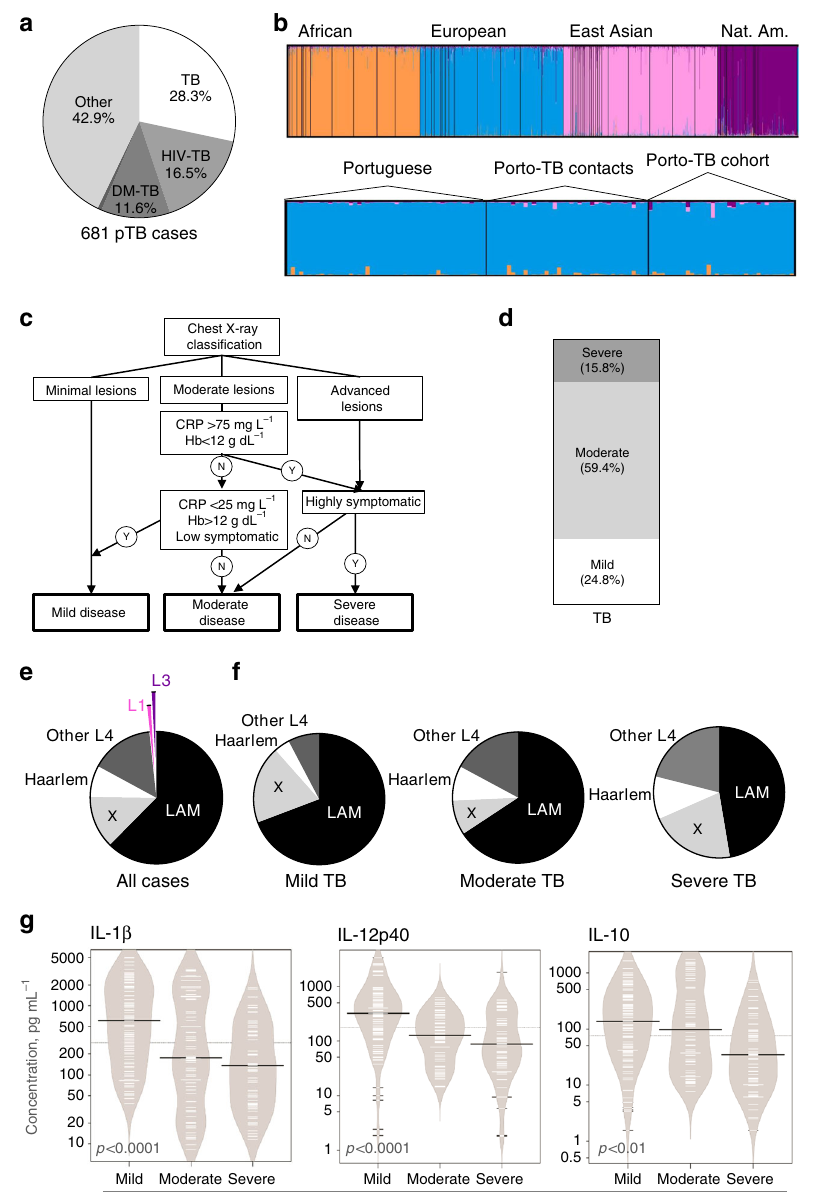
Fig. 1 M . tuberculosis clinical isolates associated with severe TB induce lower cytokine responses. a The clinical data for 681 adult pulmonary TB (pTB) cases were reviewed and classi fi ed according to the absence or presence of comorbidities. b Top panel: genetic makeup through a validated panel of autosomal ancestry-informative markers of reference populations of African, European, East Asian, and Native American biogeographical origin. Bottom panel: the genetic ancestry for a group of 60 TB patients was determined, together with TB contacts from the same area and a reference Portuguese population. Represented are European ancestry in blue, African in orange, East Asian in pink and Native American in purple. c Clinical decision system developed to classify the severity of TB at presentation in mild, moderate or severe. d Patients who had no known comorbidities ( n = 133) were classi fi ed into mild, moderate, or severe TB cases at presentation. e M . tuberculosis isolates recovered for 117 of the 133 selected TB patients were classi fi ed into lineages and those belonging to lineage 4 (L4) were further classi fi ed into L4.3/LAM, L4.1.1/X, L4.1.2/Haarlem or other lineage 4 sublineages. f Mild, moderate, and severe TB cases, as determined in d , were strati fi ed according to the sublineage, the infecting bacteria belonged to. Statistical analysis was performed with Fisher ’ s exact test. g PBMC from 8-10 IGRA + donors were infected with L4 M . tuberculosis isolated from mild ( n = 10), moderate ( n = 9), or severe ( n = 7) TB patients. An MOI of 1 was used and 24 h post-infection the amounts of secreted IL-1 β , IL-12p40, IL-10, and IFN- β quanti fi ed. Represented are bean plots for each cytokine. Black lines show the medians; white lines represent individual data points; polygons represent the estimated density of the data. IFN- β was undetected for all conditions. Statistical analysis was performed with Pearson correlation; R and p -values were: IL-1 β R = – 0.3471; R2 = 0.1205; p < 0.00001; IL-12 R = – 0.3419; R2 = 0.1169; p < 0.00001; and IL-10 R = – 0.1918; R2 = 0.0368; p = 0.002473. CRP C-reactive protein, Hb hemoglobin, LAM Latin-American and Mediterranean, N no, TB tuberculosis, Y